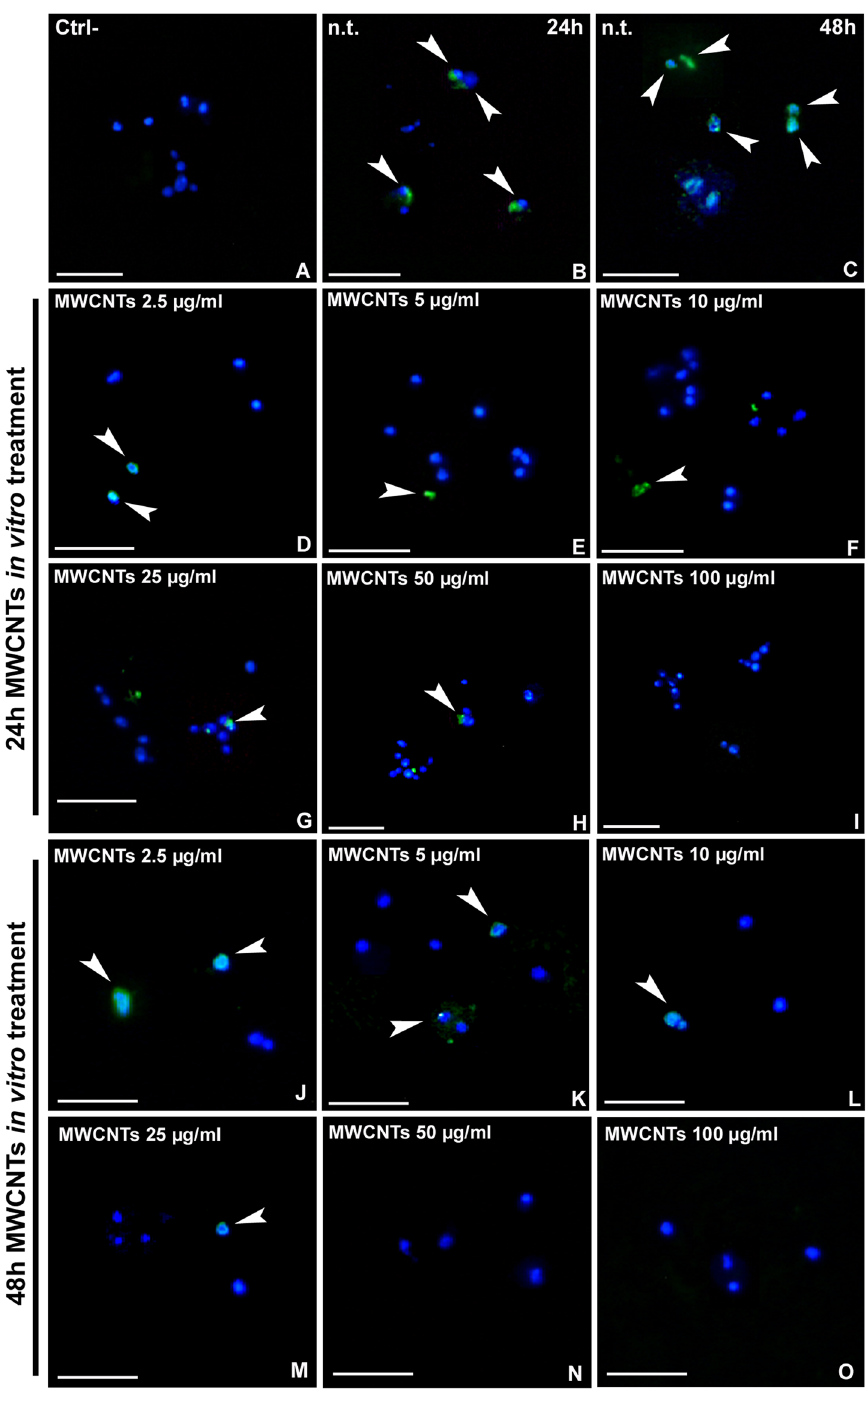
Figure 2. Proliferation assay after MWCNT in vitro treatment ( A – O ). Compared to the negative control ( A ), where the primary antibody was omitted, the major part of cells in n.t. samples are BrdU + (arrowheads) both at 24 h ( B ) and 48 h ( C ). In MWCNT treated samples, the number of positive cells decreases in dose and time dependent way ( D – O ). Nuclei are stained with DAPI (blue). Bars in ( A – O ) 20 µ